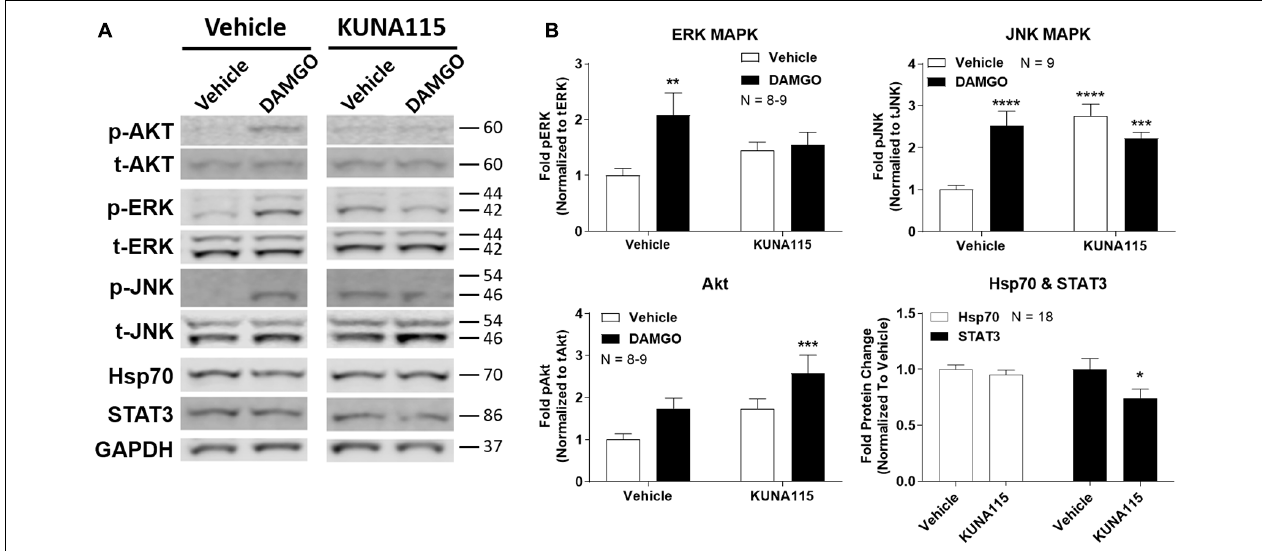
FIGURE 2 | Hsp90 α regulates opioid signal transduction in the brain. Male CD-1 mice had vehicle or 0.1 nmol KUNA115 injected icv , 24 h, followed by vehicle or 0.1 nmol DAMGO icv , 10 min. Periaqueductal gray region analyzed by Western blot. All data reported as the mean ± SEM, with sample sizes of mice/group noted in each graph; all experiments performed in four technical replicates. For ERK, JNK and Akt, data analyzed by two-way ANOVA with Fisher’s Least Significant Difference post hoc test; ∗∗ , ∗∗∗ , ∗∗∗∗ p < 0.01, 0.001, 0.0001 vs. Vehicle:Vehicle group. For Hsp70 and STAT3 data analyzed by Unpaired 2-Tailed t -test; ∗ p < 0.05 vs. same target Vehicle group. (A) Representative sample blots shown for each target, with MW indicated for each protein. Each pair of images for one target (e.g., p-Akt) were from the same blot, but discontinuous, so they are separated to denote this fact. (B) All Western data quantitated by target. ERK, JNK, and Akt are phosphorylated protein signal normalized to total protein. Hsp70 and STAT3 are normalized to GAPDH. KUNA115 treatment caused a loss of ERK and JNK stimulation over baseline by DAMGO, and a loss of STAT3 protein